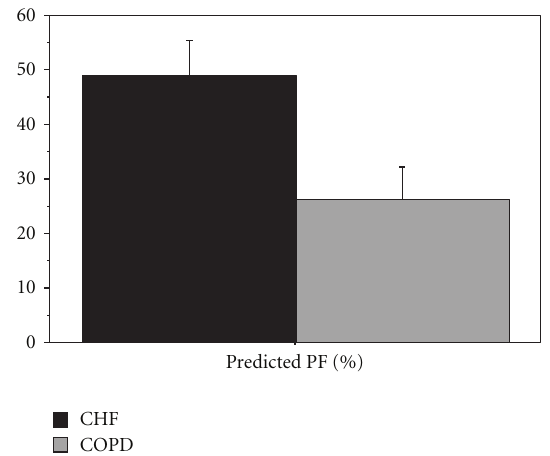
Figure 1: % Predicted peak flow measurement: COPD versus CHF.